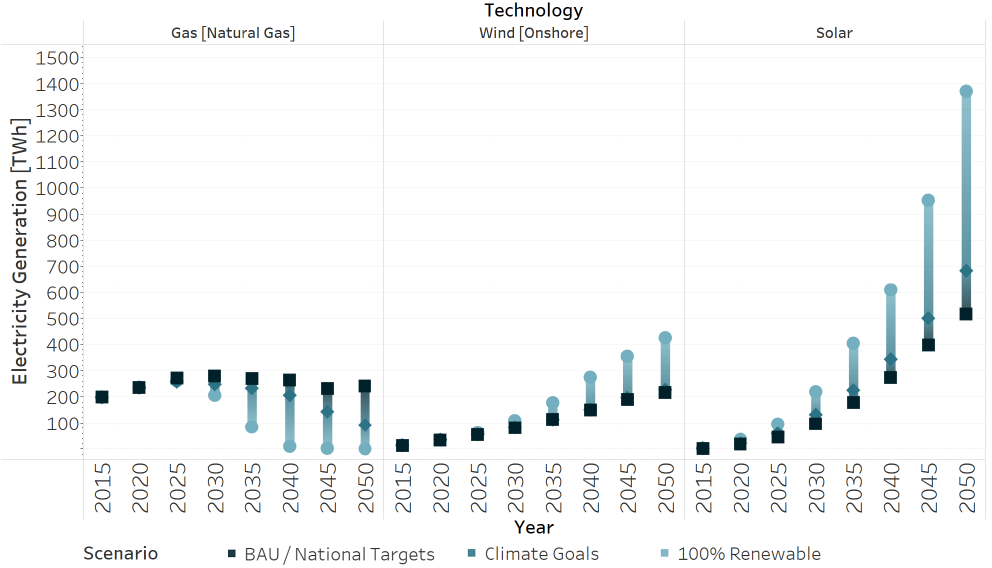
Figure 7. Electricity generation from nat. gas, solar photovoltaic (PV) and onshore wind energy per